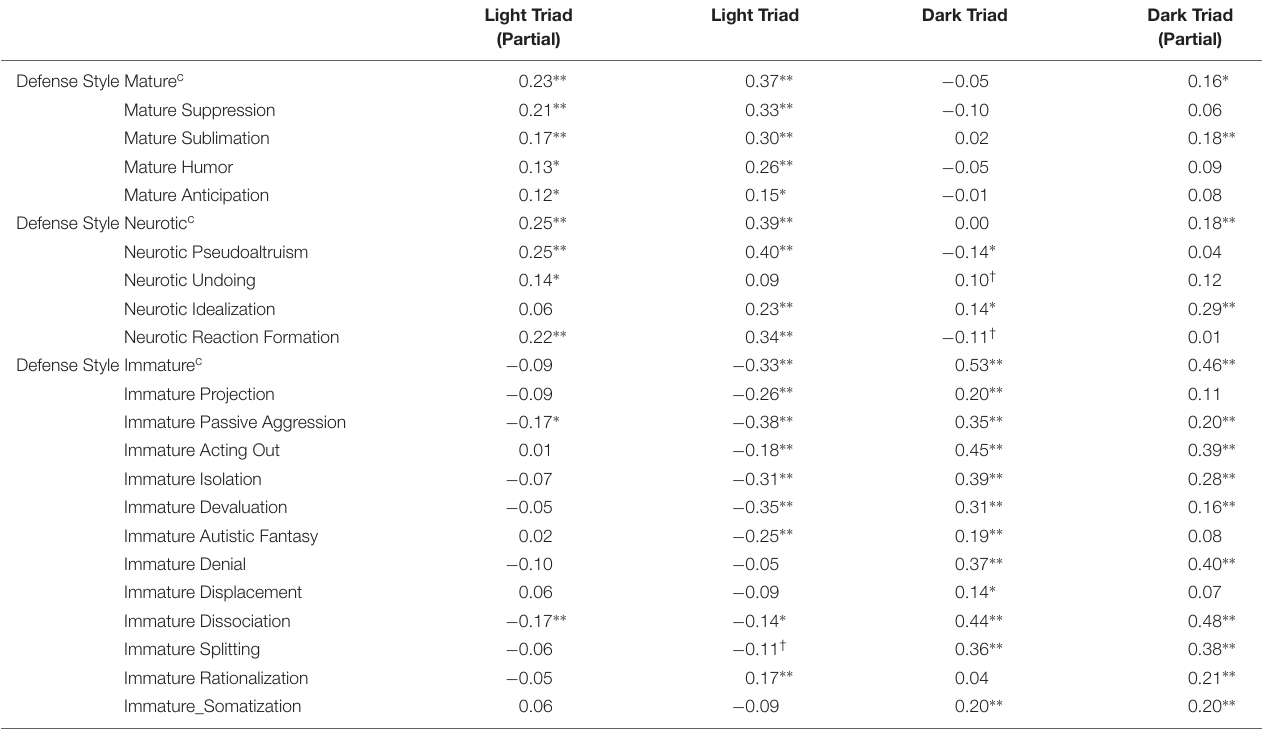
TABLE 9 | Correlations and partial correlations between defense styles and light vs. dark triad.